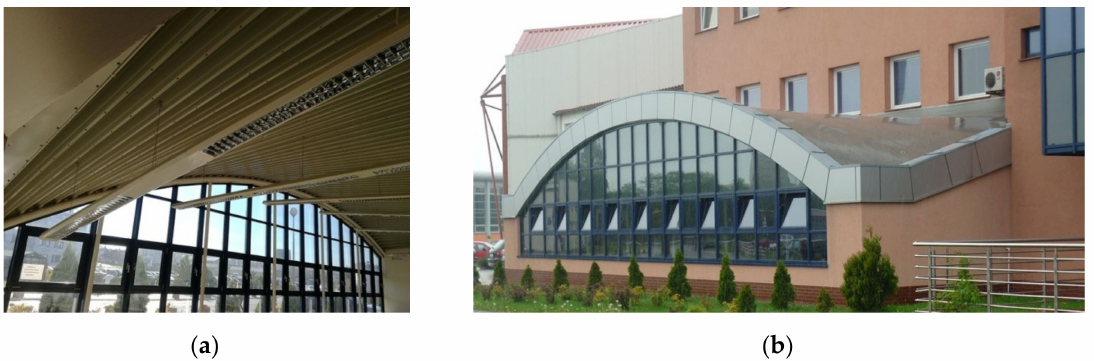
Figure 6. A transformed roof shell whose inside bottom layer is folded sheeting: ( a ) view from the inside; ( b ) view from the